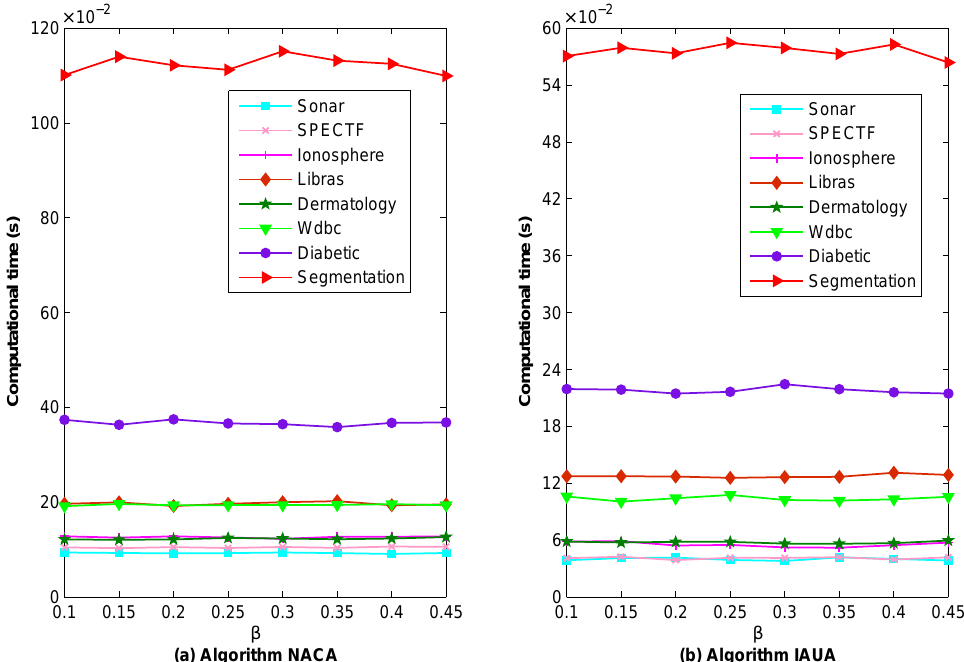
Figure 3. A comparison of NACA and IAUA with changing values of the parameter β